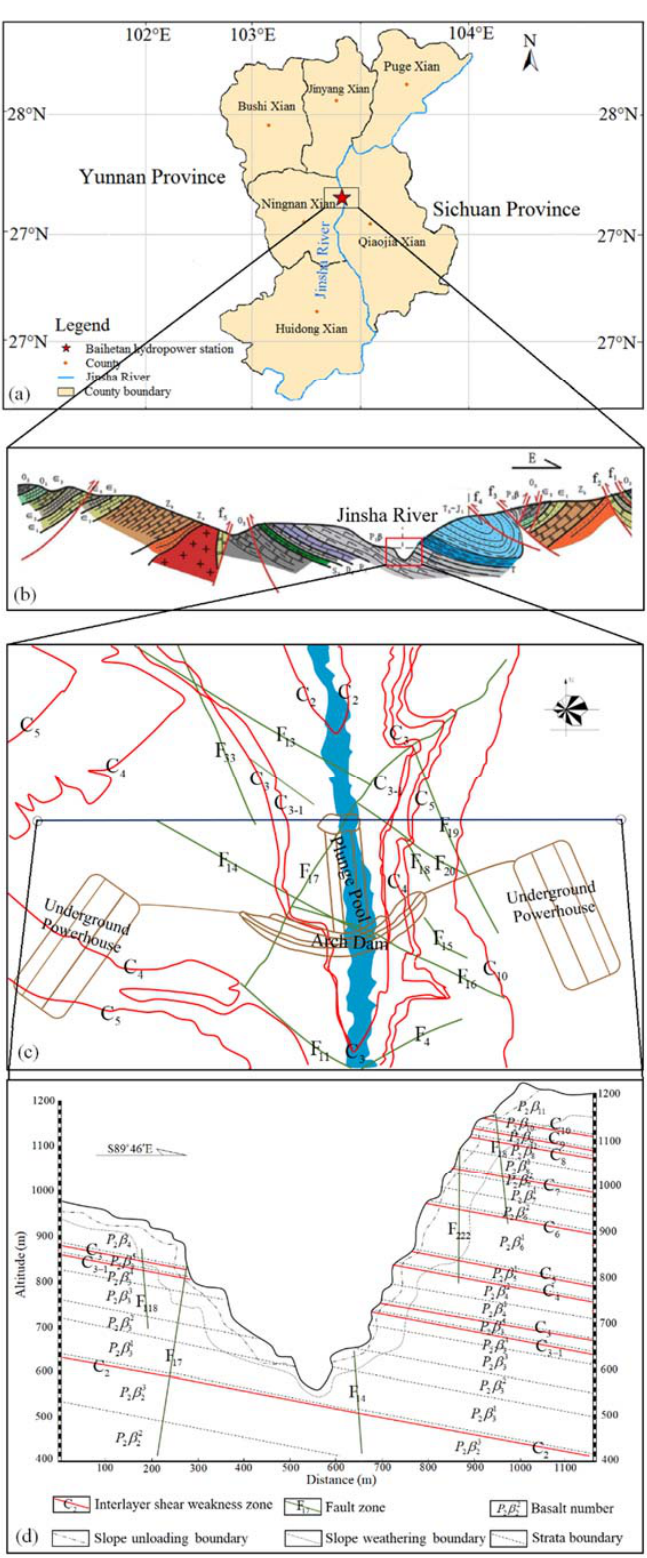
Figure 1. Several maps of the Baihetan dam site. ( a ) Geographical location map; ( b ) Geological section map; ( c ) Distribution diagram for the main structural planes; ( d ) Simplified diagram of spatial distribution of some main hydrogeological structures.